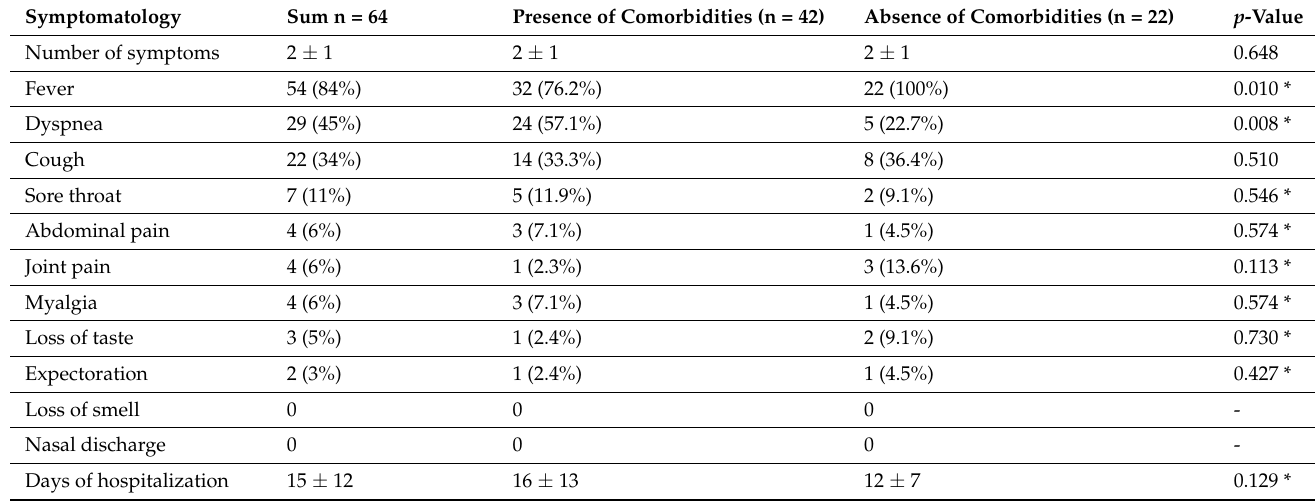
Table 3. Population’s symptomatology during admission and their comparison based on the presence or absence of comorbidities n = 64.